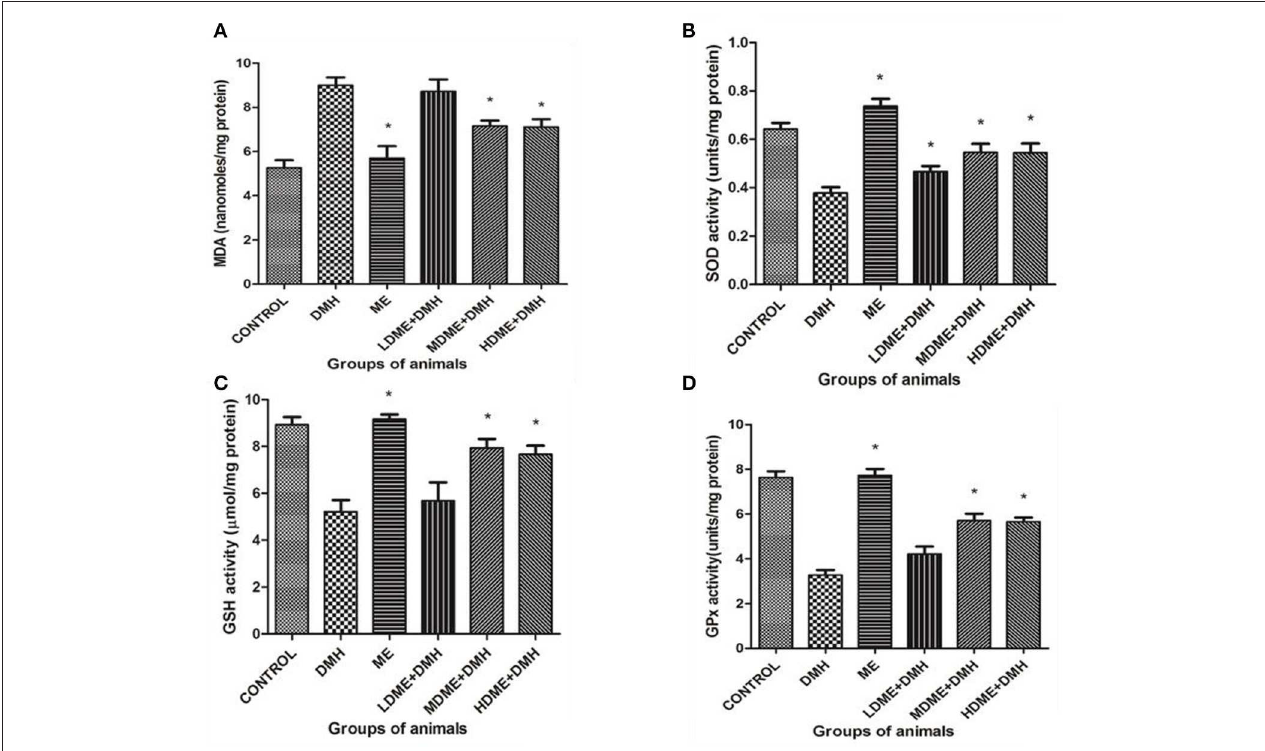
FIGURE 5 | Oxidant and antioxidant levels in animals belonging to different groups: (A) malondialdehyde (MDA), (B) superoxide dismutase (SOD), (C) reduced glutathione (GSH), and (D) glutathione peroxidase (Gpx) levels. Experiment was performed in triplicates. Values are expressed as mean ± SD, * p < 0.05 vs. 1,2-dimethylhydrazine